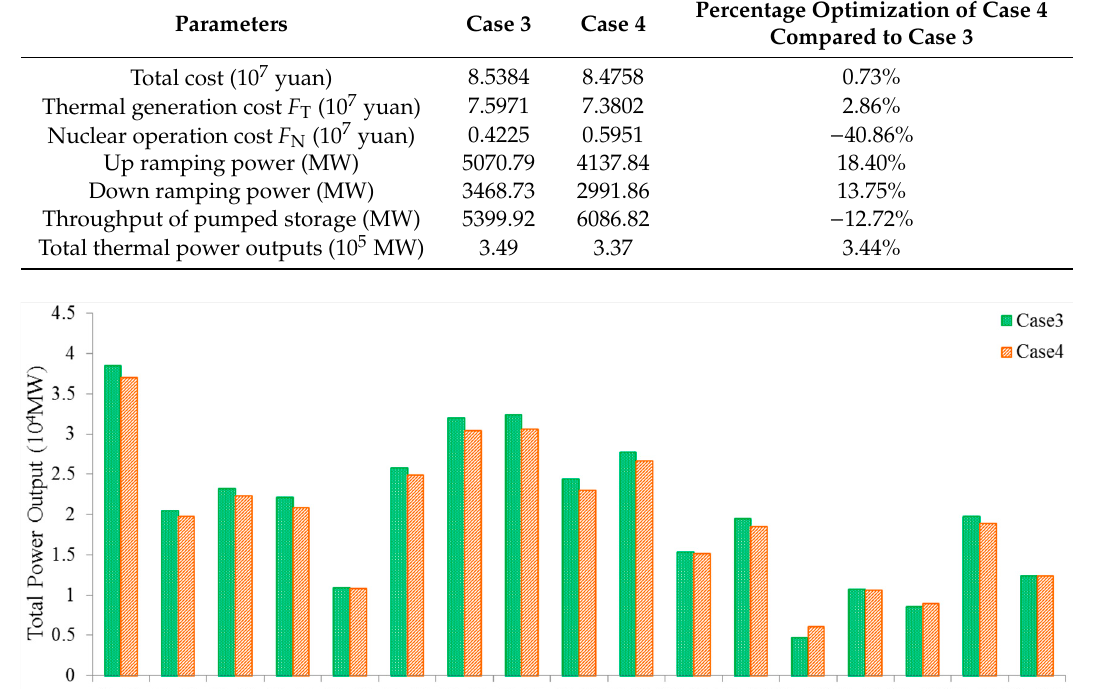
Figure 16. Total thermal power outputs of each unit in Case 3 and Case 4.